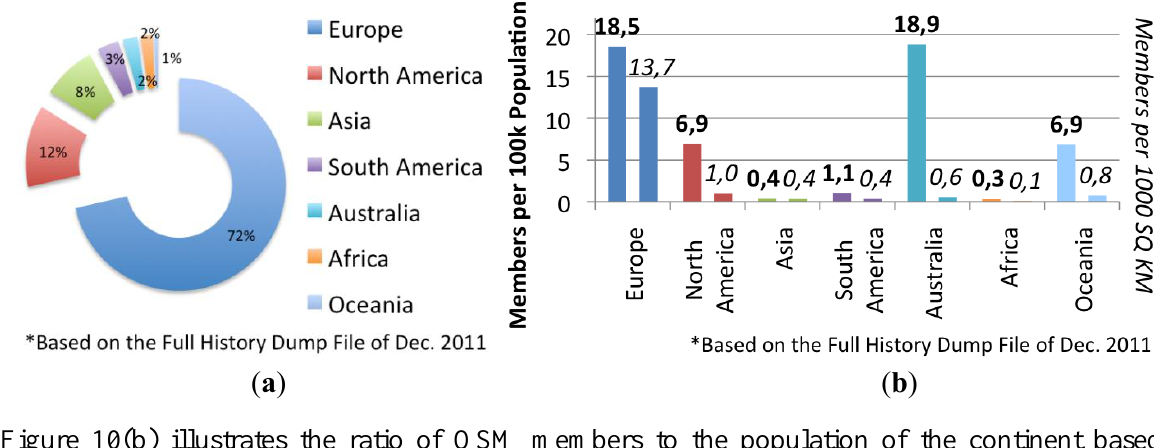
Figure 10. ( a ) Contributors per continent* and ( b ) ratio of members to population per continent*.